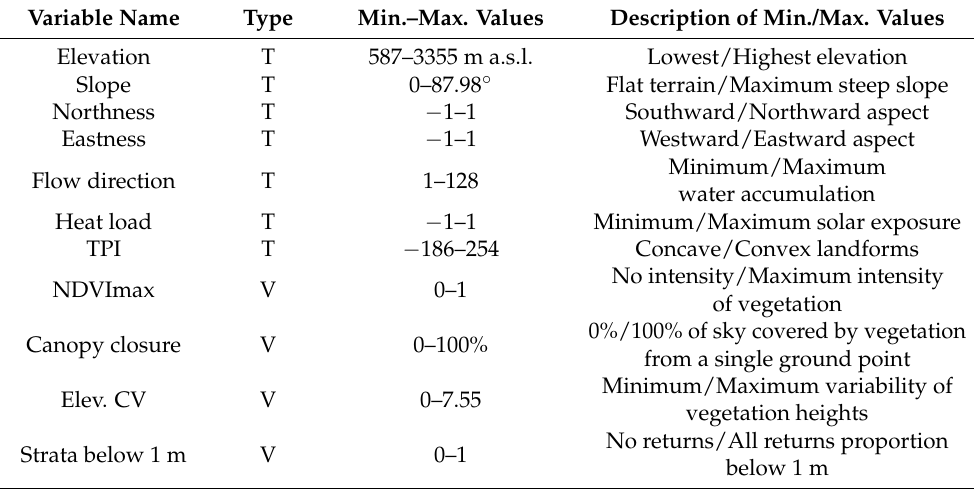
Table 2. List of environmental variables selected to model microclimatic and refugial capacity metrics. T = Topographic variable; V = Vegetation